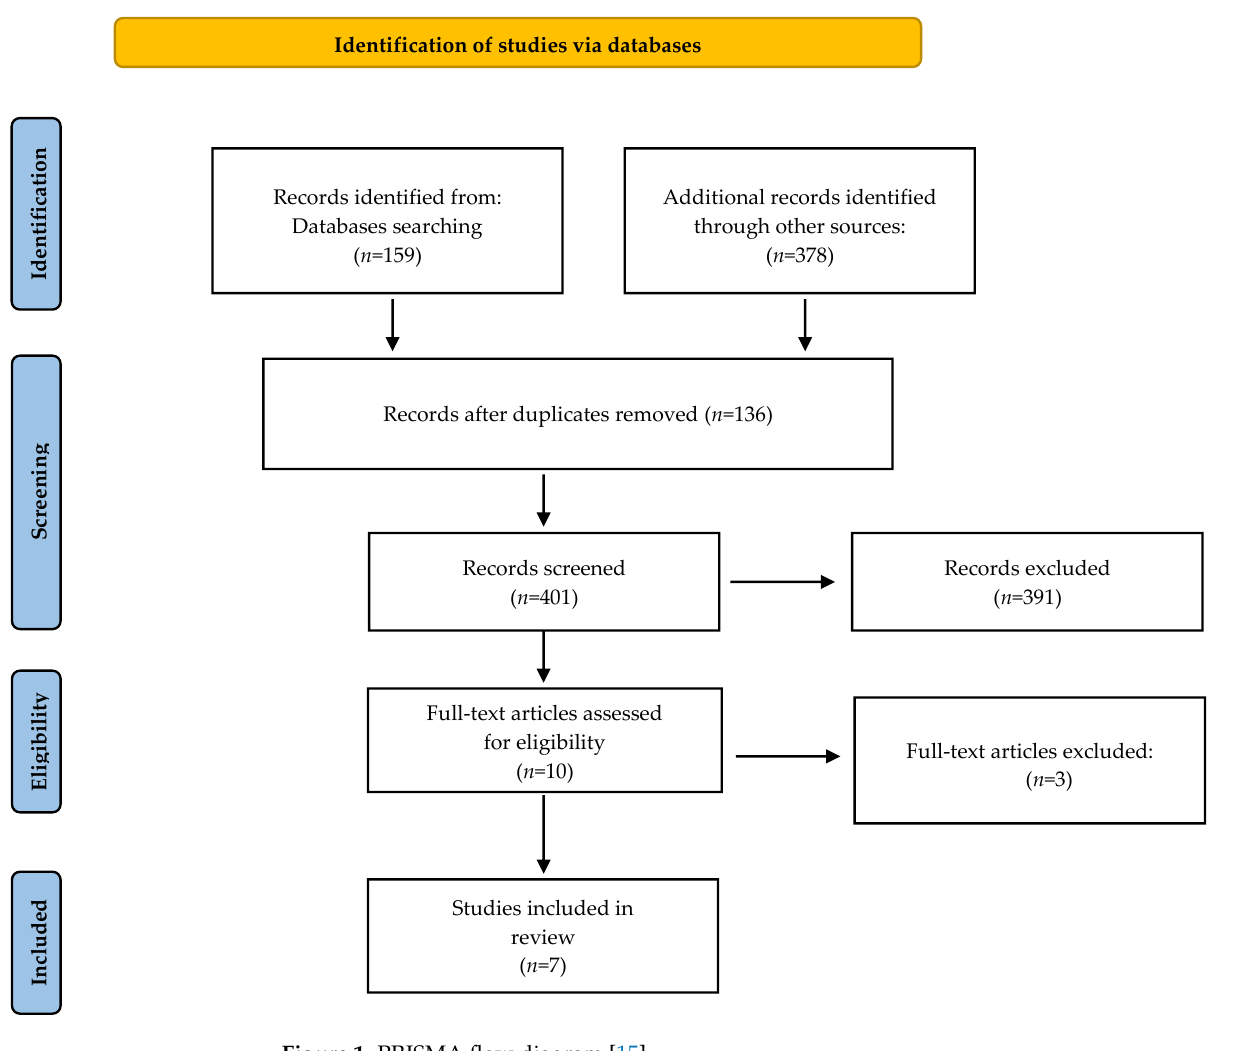
Figure 1. PRISMA flow diagram [15]. Table 3. Tabular presentation of qualitative findings for a scoping review.